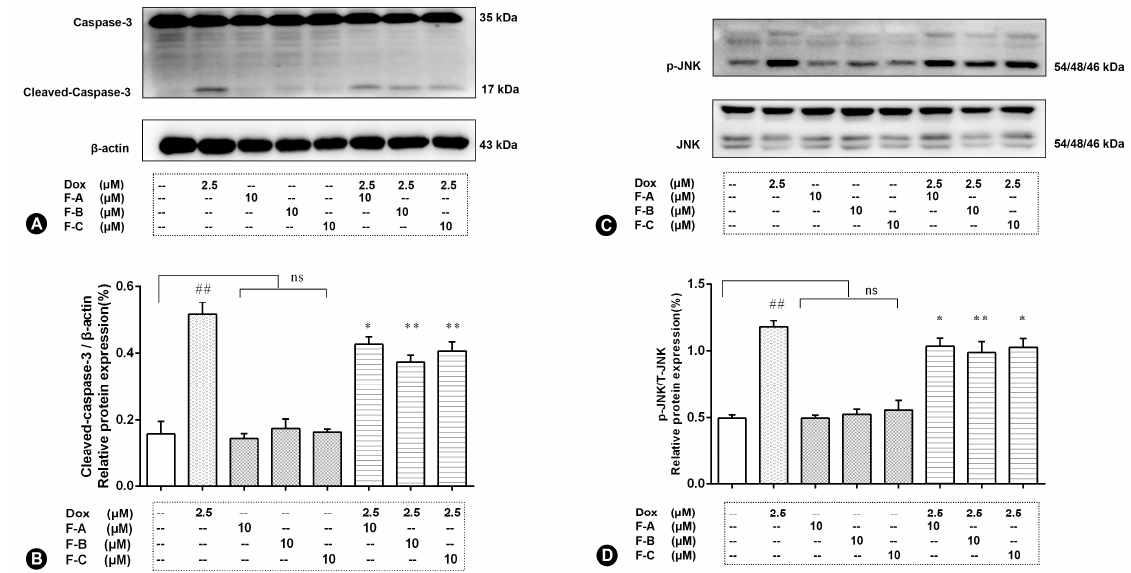
Figure 3. Flavonoids from Hippophae rhamnoides Linn affect the protein expression level of cleaved caspase-3 ( A , B ) and p-JNK ( C , D ) in Dox-induced H9c2 cells. Cells were pretreated with same concen- trations of F-A, F-B, and F-C (10 µ M) for 1 h, then exposed to Dox for 24 h. Relative folds of cleaved caspase-3, p-JNK. ( B ) The relative expression level of cleaved caspase-3 in Dox group significantly increased compared to the NC group ( p < 0.01). There was no significant activation of cleaved caspase-3 in the F-A, F-B, and F-C group without Dox. But F-A, F-B, and F-C can significantly inhibit the Dox- induced activation of caspase-3 in comparison to the Dox model group ( p < 0.01). ( D ) H9c2 cells treated with 2.5 µ M Dox rapidly increased the relative expression level of phosphorylation of JNK ( p < 0.01). Compared to the NC group, F-A, F-B, and F-C with the absence of Dox has no significant increase in the expression level of p-JNK. The expression levels of p-JNK compared to the Dox group was significantly suppressed by the administration of F-A, F-B, and F-C in the presence of 2.5 µ M Dox ( p < 0.01). Results are mean ± SEM from three independent experiments. ## p < 0.01 vs. control, * p < 0.05, ** p < 0.01 vs. Dox group. ns, not significant.